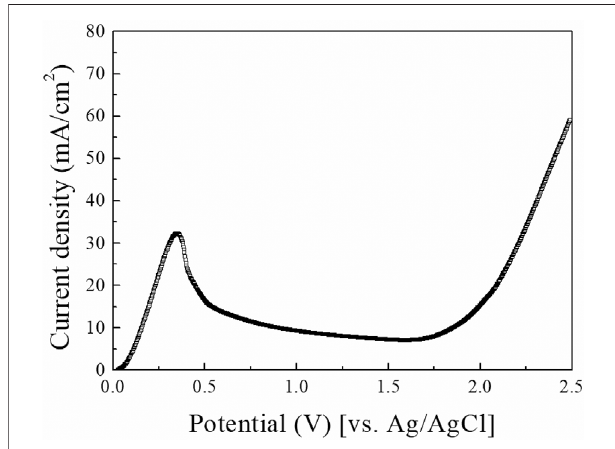
FIGURE 3 | Linear scan voltammogram of Cu substrate in 85% phosphoric acid. A sweep was done with a scan rate of 10 mV/s.